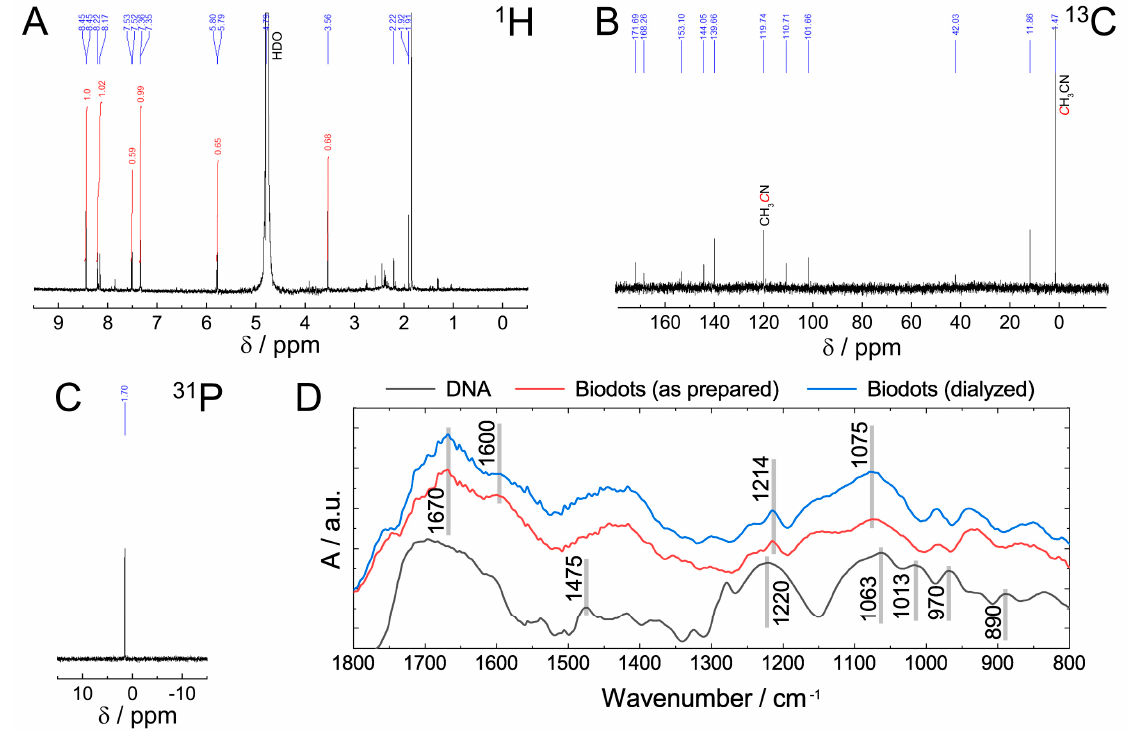
Figure 3. Characterization of biodots prepared from DNA. ( A – C ) 1 H ( A ), 13 C ( B ), and 31 P ( C ) NMR spectra of DNA biodots in D 2 O. ( D ). FTIR spectra of DNA, and DNA biodots before and after dialysis.